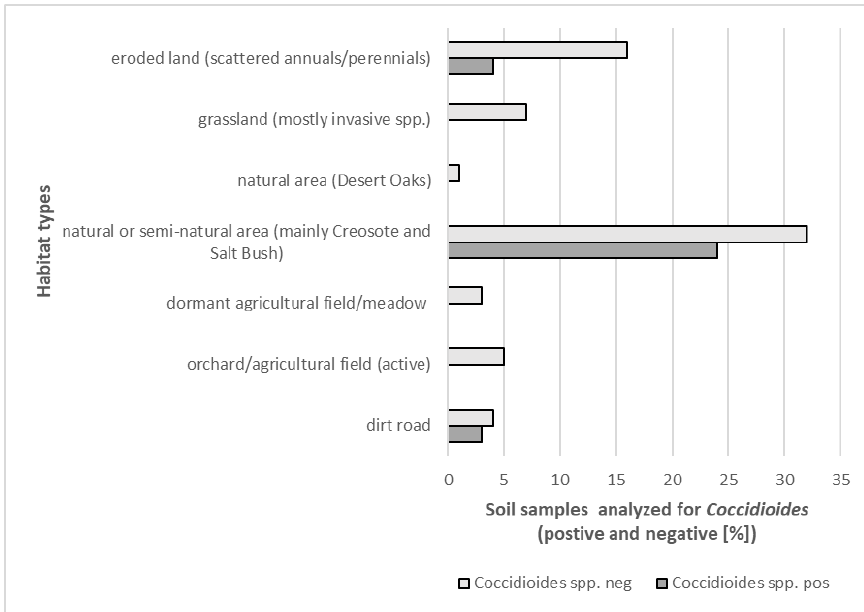
Figure 10. Detection of Coccidioides DNA in habitats that differ in the degree of human influence. Statistically significant differences were determined between different habitat types and the presence or absence of the pathogen DNA ( p -values < 0.001, linear regression; see Methods and text).